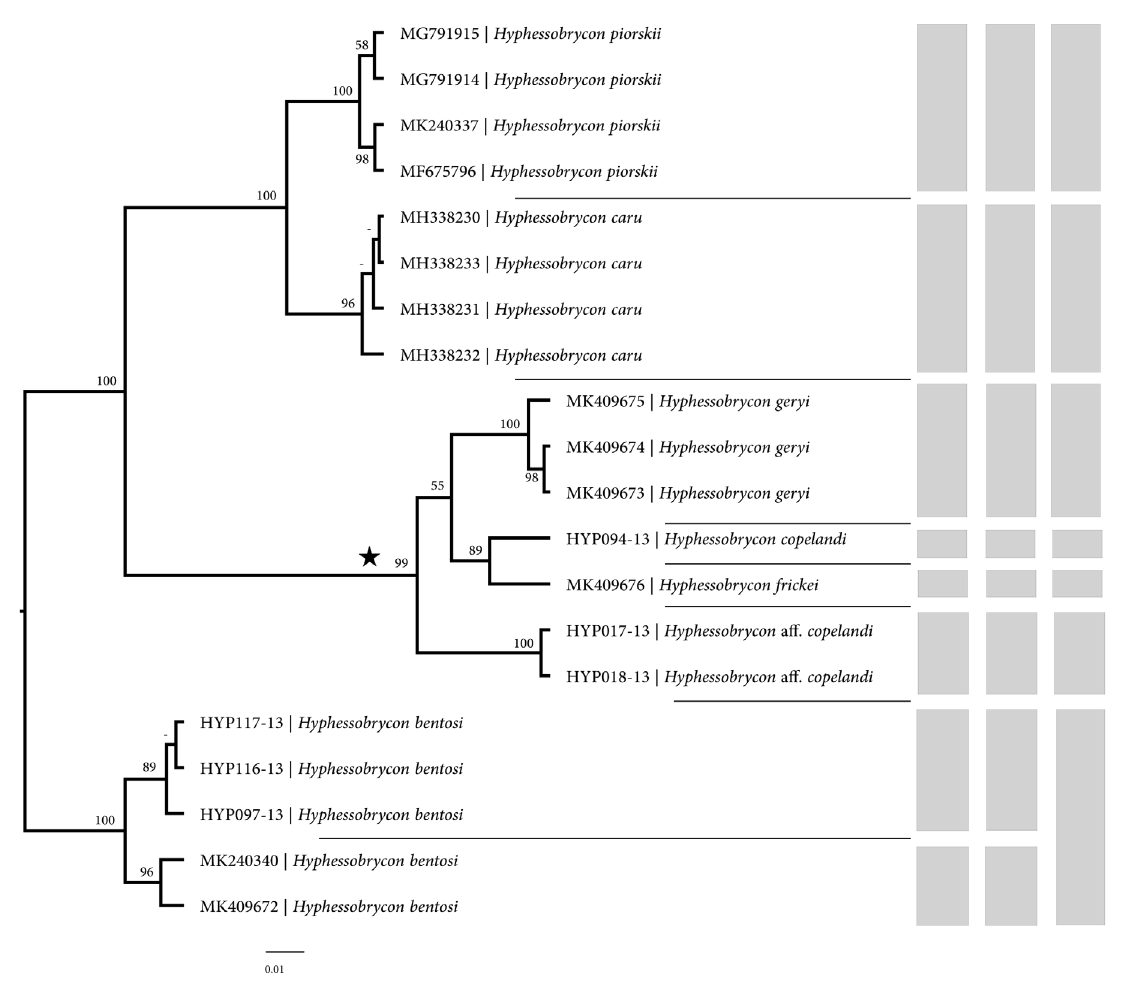
Fig. 8. Topology of the ultrametric tree performed in BEAST ver. 1.8.4 including unique haplotypes summarizing the results of GMYC, bPTP and ABGD. Numbers above and below branches are posterior probability values. The star indicates the Hyphessobrycon copelandi